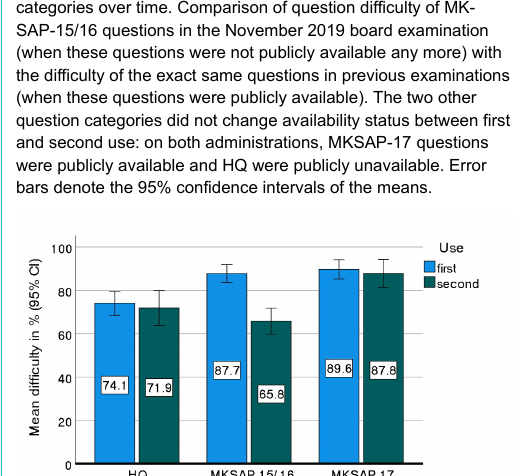
Figure 2: Change of question difficulty of three different question categories over time. Comparison of question difficulty of MK-